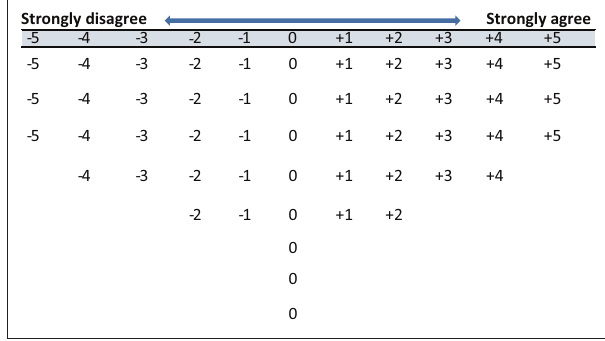
FIGURE 1: Sample of a distribution